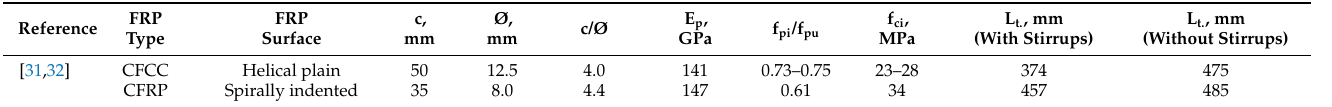
Table 5. Summary of transfer length results under the influence of shear